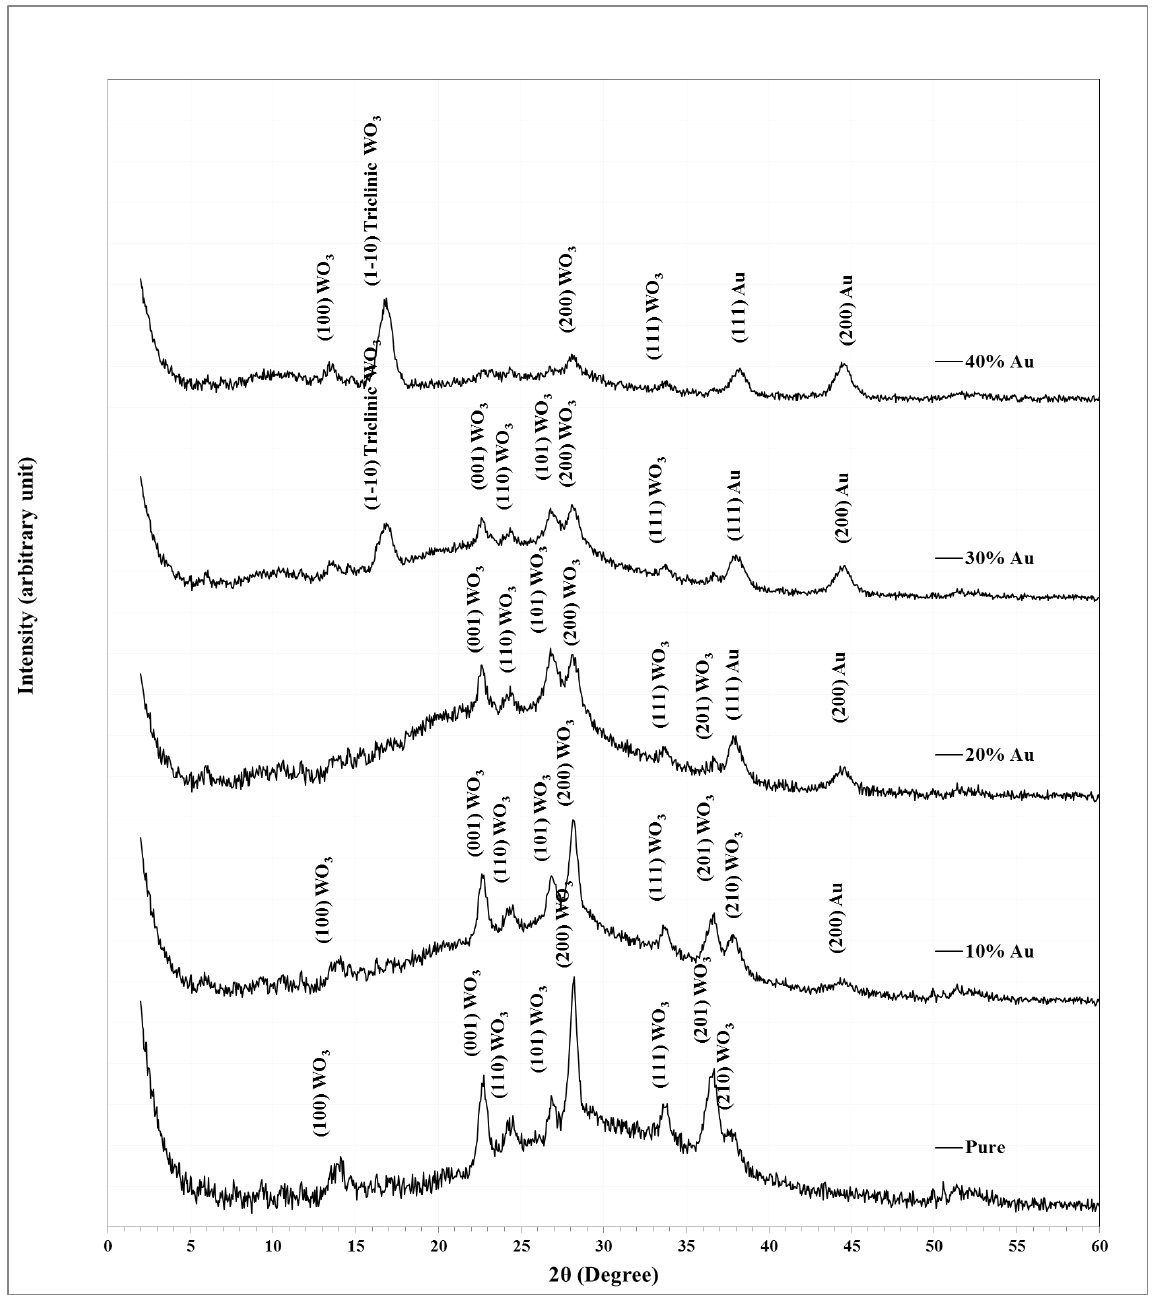
Fig. 2: The XRD pattern of WO